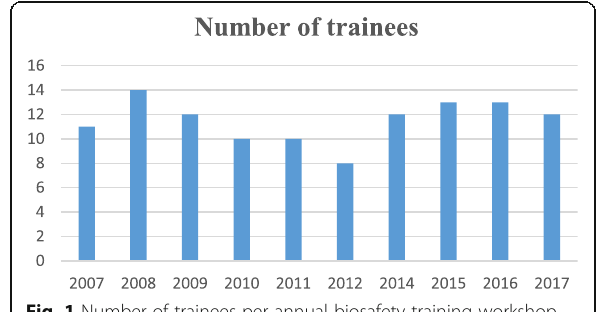
Fig. 1 Number of trainees per annual biosafety training workshop